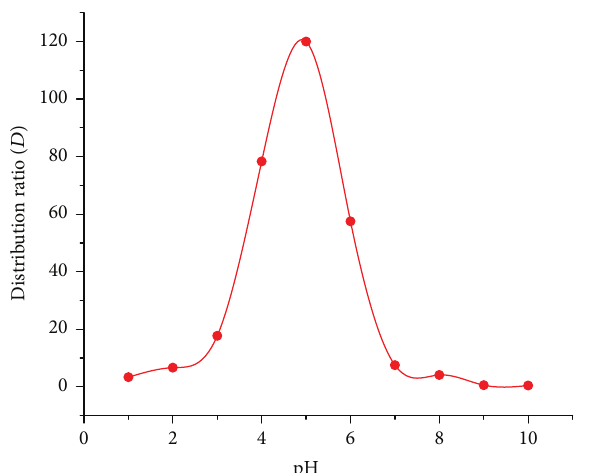
Figure 4: Effect of pH on the distribution ratio ( 𝐷 ).